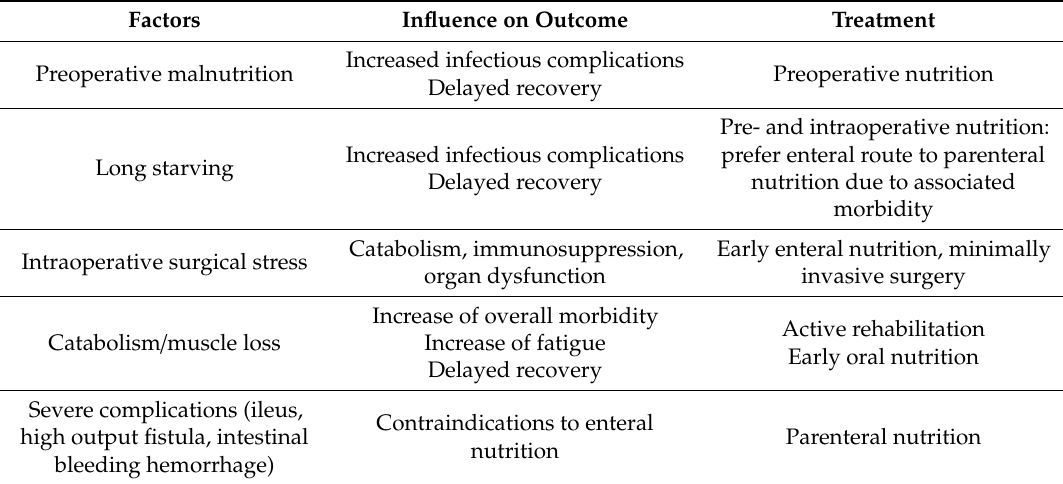
Table 1. Indications to nutritional